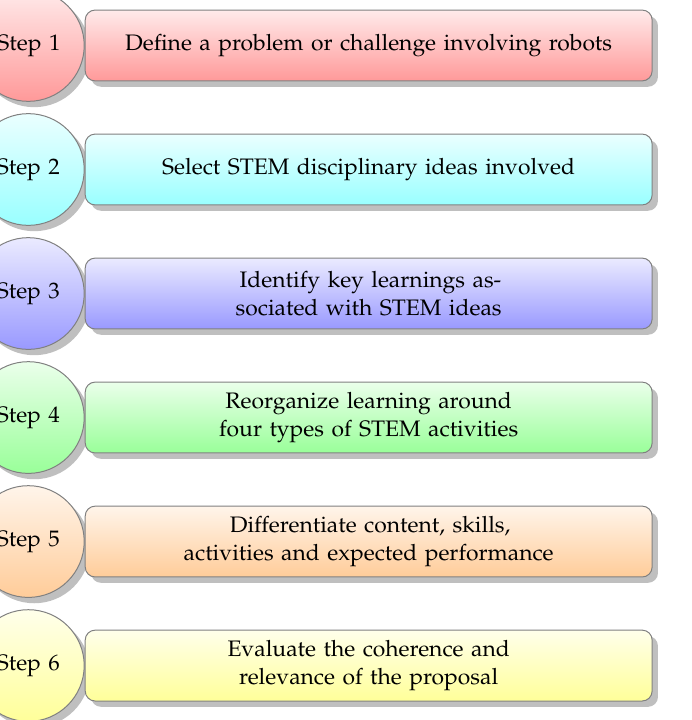
Figure 1. Proposal to incorporate the knowledge of robotics for the promotion of STEM learning in a multigrade